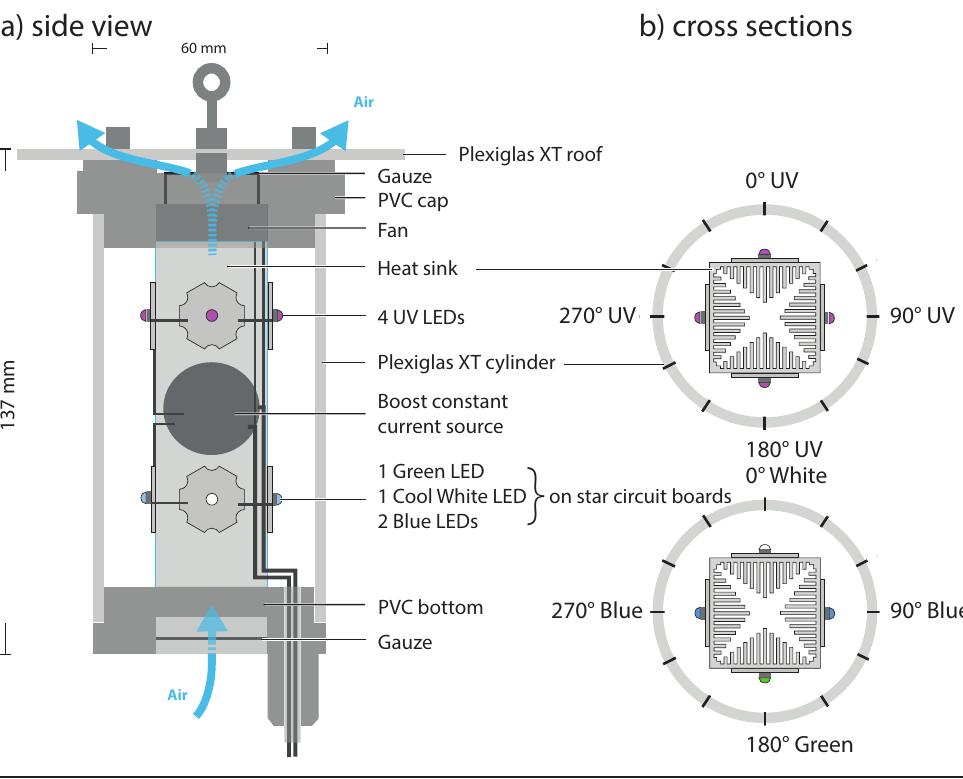
Figure 2. Design of the new LED lamp (scale 1:2). A total of 8 Power LEDs is arranged at two levels (4 UV, 2 blue, 1 green, 1 cool